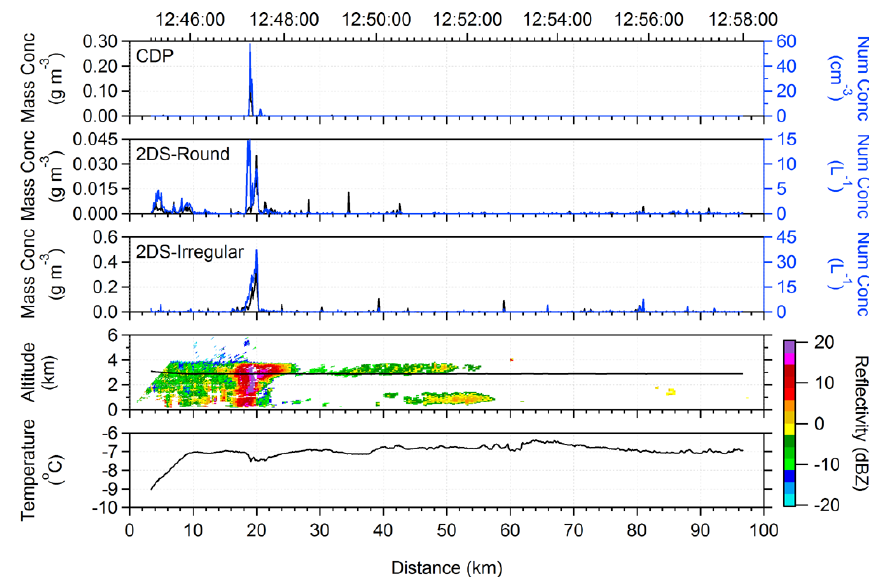
Fig. 7. Same as Fig. 5, except for run R4. The CAMRa RHI scan shown is from (12:51:12–12:53:12 UTC).